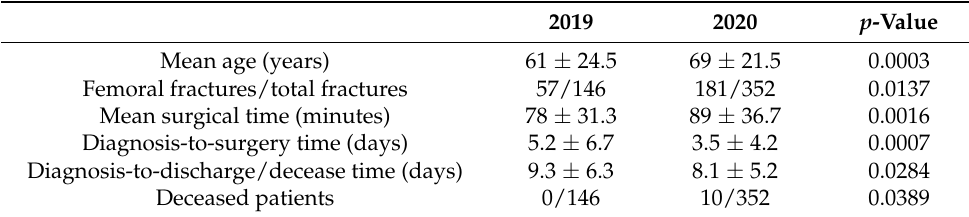
Table 1. Differences in patients admitted between 2019 and 2020.